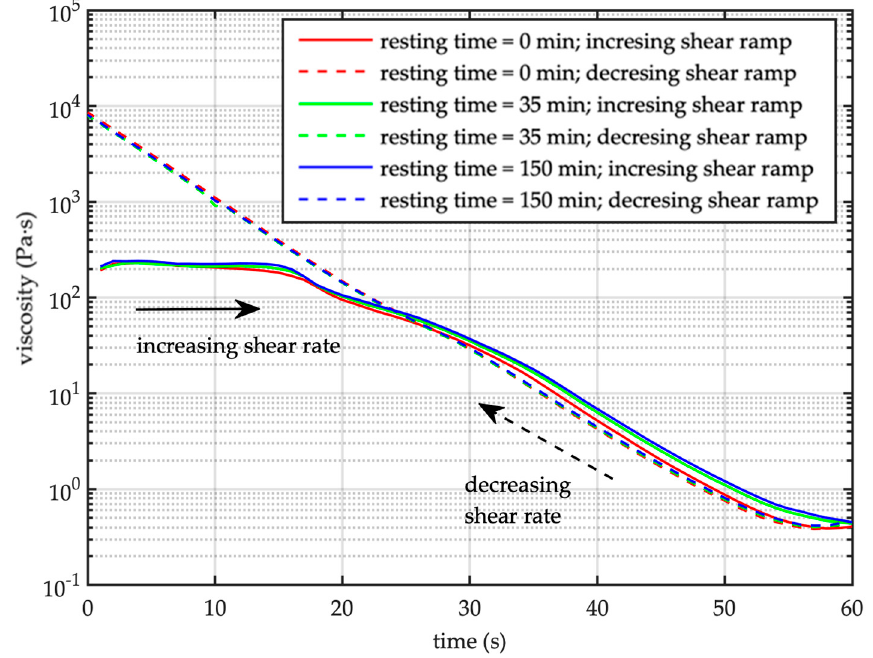
Figure 9. Apparent viscosity derived from the flow curves ( C = 52%) after different resting times (runs F9, F10, F11 in the legend from the top to the bottom). ⎯ increasing shear ramp (time 0–60 s); - - decreasing shear ramp (time 60–0 s). Runs F24, F25 and F26 were carried out to study the thixotropy behavior of the mix- ture having a sediment concentration C = 50%, sheared at very low shear rate (i.e., 𝛾(cid:4662) (cid:3404) (cid:4670)10 (cid:2879)(cid:2872) , 10 (cid:2879)(cid:2869) (cid:4671) s − 1 ) applying different resting times (0, 3, and 10 min, respectively, for runs